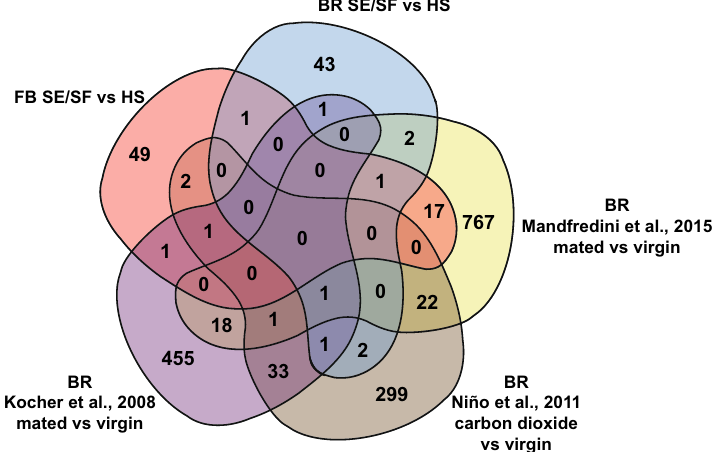
Figure 6. Venn diagram analysis of DEGs regulated in SF and SE queens as compared to HS queens and DEGs from previously published works. BR indicates that the tissue examined was brain and FB indicates that the tissue examined was fat